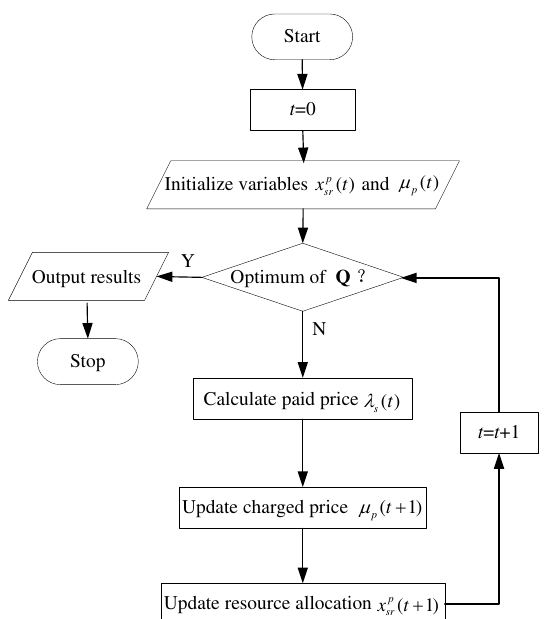
Figure 3. The flowchart of resource allocation scheme for enterprise applications deployment.